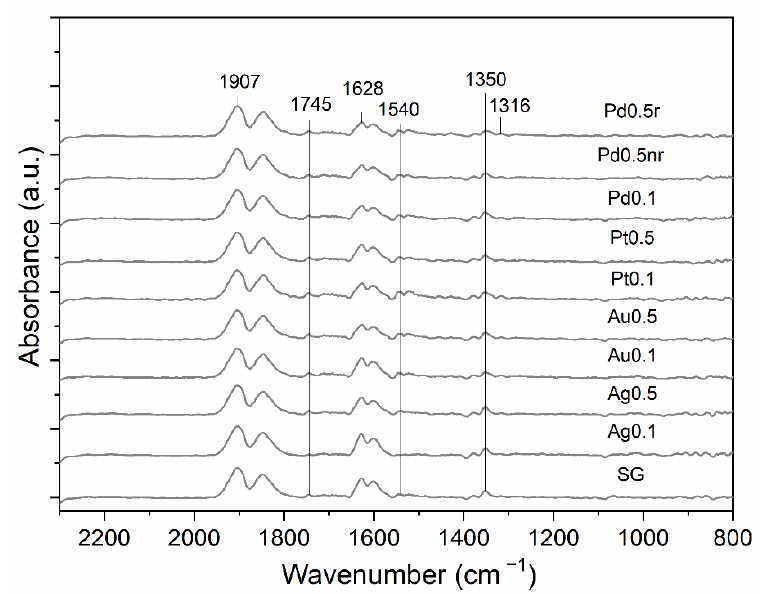
Figure 3. FTIR spectra of gas mixture obtained at 60th min of photocatalysis with NO initial concen- tration equal to 150 ppm.